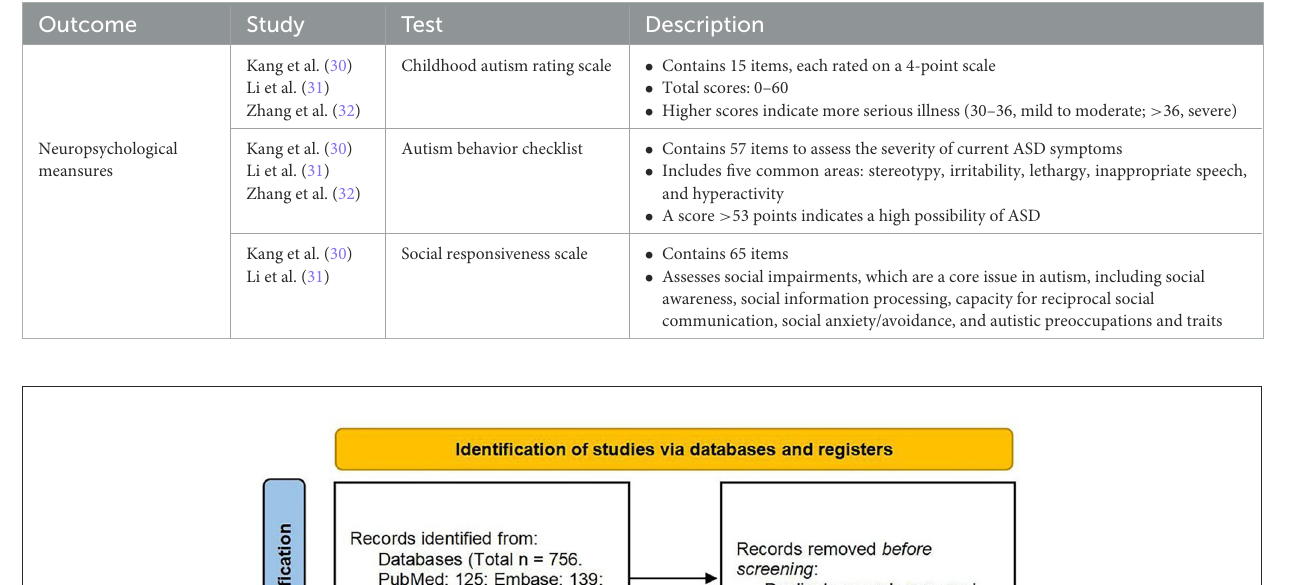
TABLE 2 Summary of collected neuropsychological test scores in the systematical review and meta-analysis.